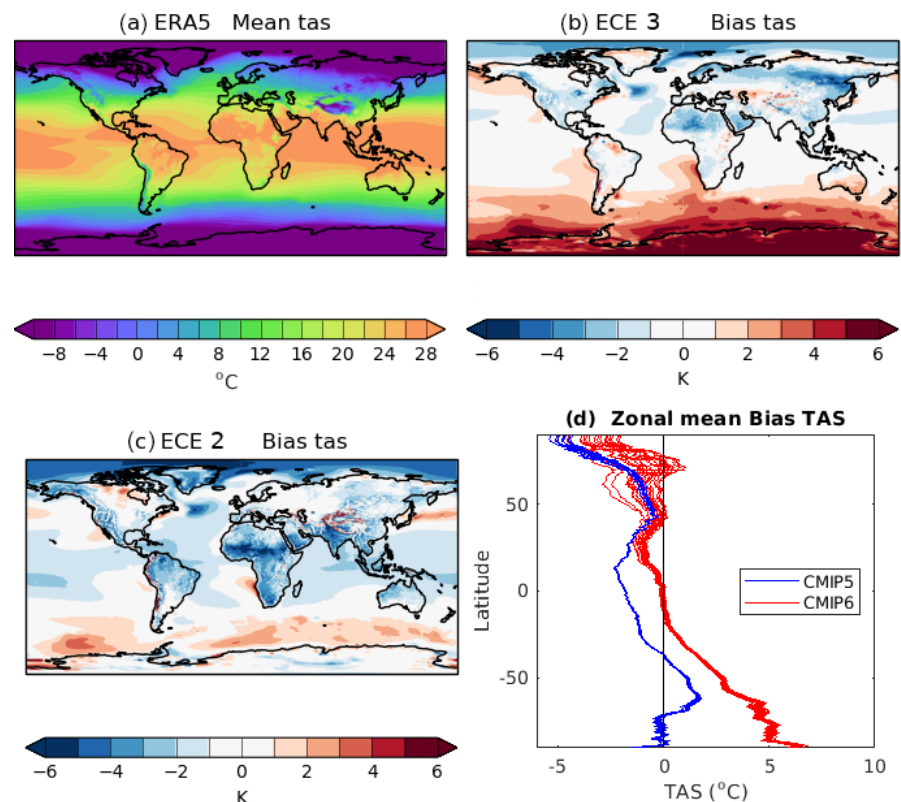
Figure 5. (a) ERA5 1980–2010 mean TAS (in ◦ C); (b) EC-Earth3 and (c) EC-Earth2.3 ensemble mean biases compared to ERA5 ( ◦ ); (d) zonal annual mean TAS from the EC-Earth2.3 (blue, CMIP5) and EC-Earth3 (red, CMIP6)